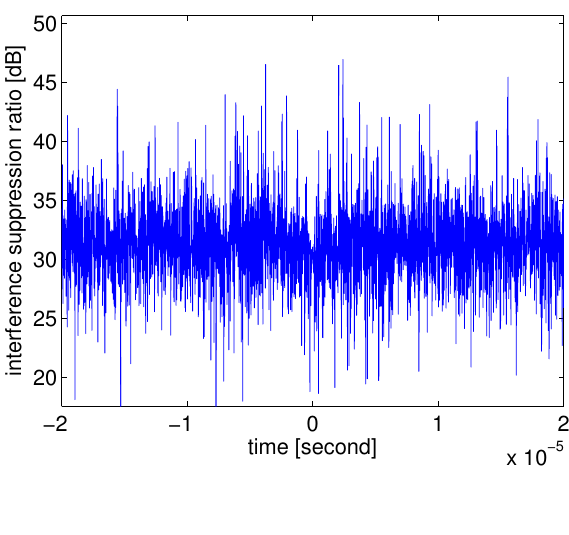
Figure 11. Result of the interference suppression